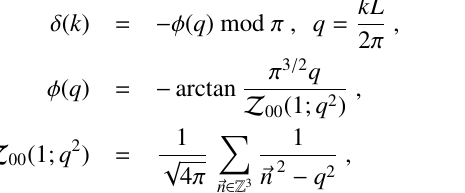
Figure 3. The S-wave amplitude f 0 + for K − p → K − p for I = 0 in the complex energy plane clearly showing the two poles in the region of the Λ (1405). The red band indicates that the ( + + - - - - + + + + ) Riemann sheet is only connected to the real energy axis between the ¯ KN and the π Σ thresholds. For the definitions of the sheets, see e.g. Ref. [5]. Figure courtesy of Maxim